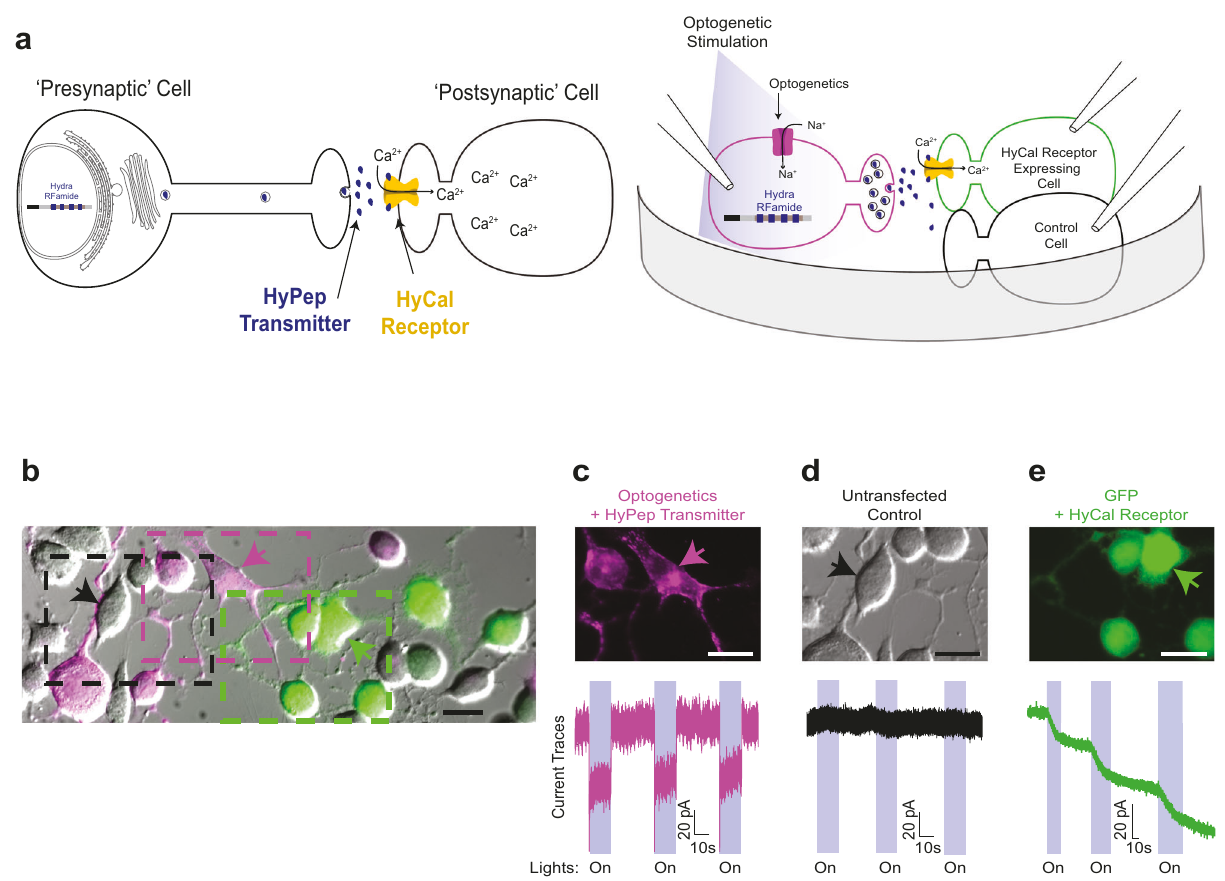
Fig. 1 Hydra-derived synthetic synapse (HySyn) engineered through heterologous expression of Hydra neuropeptide (HyPep) and receptor (HyCal). a (left) Schematic describing “ HySyn ” : Hydra -derived neuropeptide (blue) is released from the “ presynaptic ” cell and interacts with the HyCal receptor (yellow) to fl ux calcium in the “ postsynaptic ” cell. a (right) Schematic illustrating the experimental paradigm to assay HySyn function by whole-cell patch- clamp electrophysiology. b Micrograph showing co-culture of Neuro2a neuroblastoma cells expressing either “ presynaptic ” HyPep with ChRoME (magenta), “ postsynaptic ” HyCal with GFP (green), or untransfected (grayscale). Boxed regions correspond to the micrographs in c – e , with the color of the box matched to the color of the title of the micrograph. c – e Identi fi cation of cell populations based on fl uorescent markers (top, micrograph, 20 μ m scale bar) enabling whole-cell current recording (bottom, “ current traces ” ) from three distinct populations during optogenetic stimulation (480 nm, blue-shaded windows in “ current traces ” , “ On ” ): c “ presynaptic ” cells expressing HyPep with ChRoME (pseudocolored magenta) consistently produced step-wise optogenetic currents, d unlabeled cells remain unaltered by optogenetic activation of neighboring HyPep + cells, and e green “ postsynaptic ”